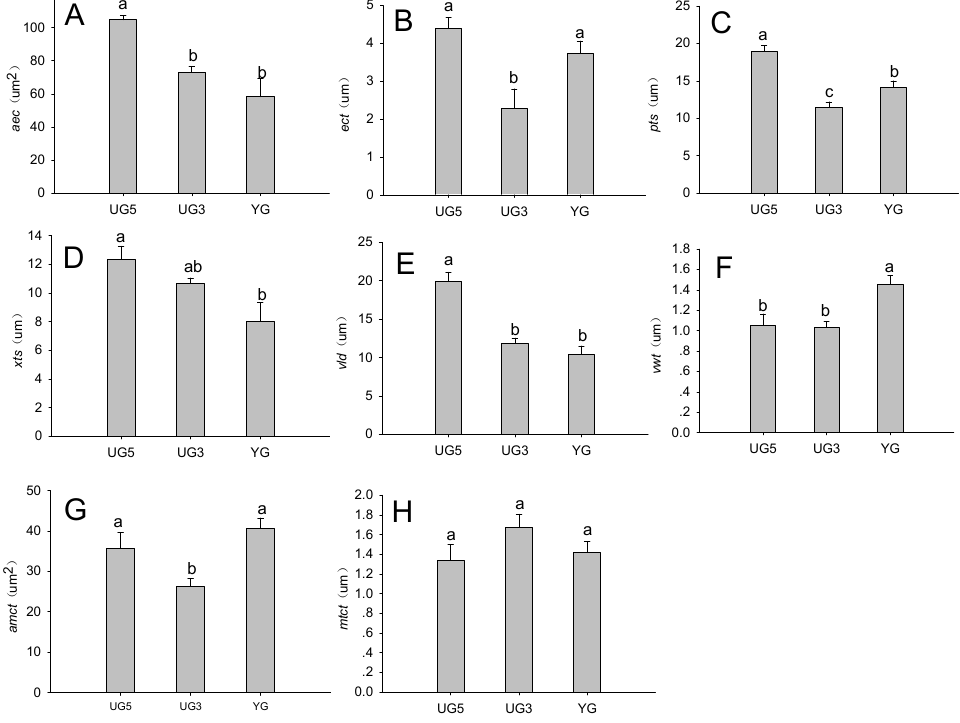
Figure 3. Effects of overgrazing and enclosed on ( A , B ) stem epidermis, ( C , D ) stem vascular bundle, ( E , F ) stem vessel, and ( G , H ) stem mechanical tissue. Significant differences are indicated by lowercase letters ( p < 0.05). Data are presented as the mean ± standard error. Abbreviations: aec , area of epidermal cells; ect , epidermal cuticle thickness; pts , phloem thickness; xts , xylem thickness; vld , vessel diameter; vwt , vessel wall thickness; amtc , area of mechanical tissue cells; mtct , mechanical tissue cell